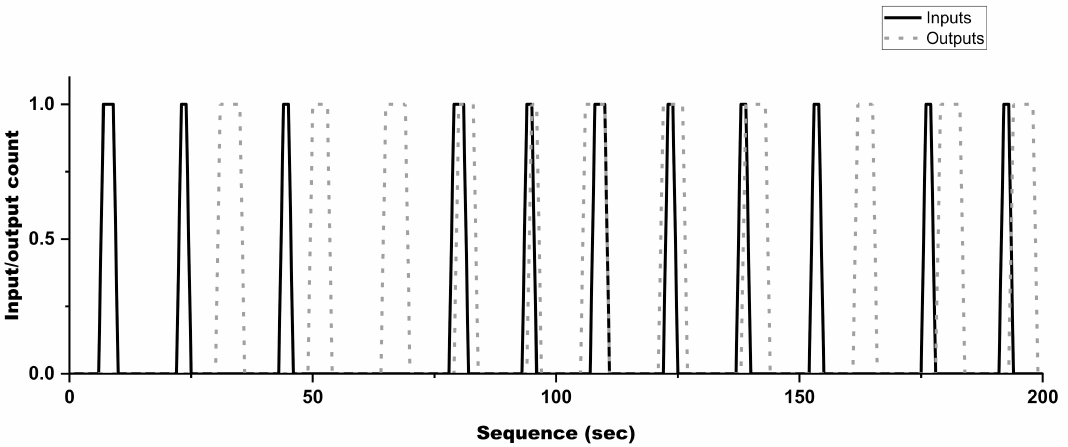
Figure 10. The inputs by machine (a) and outputs from the machine (c).